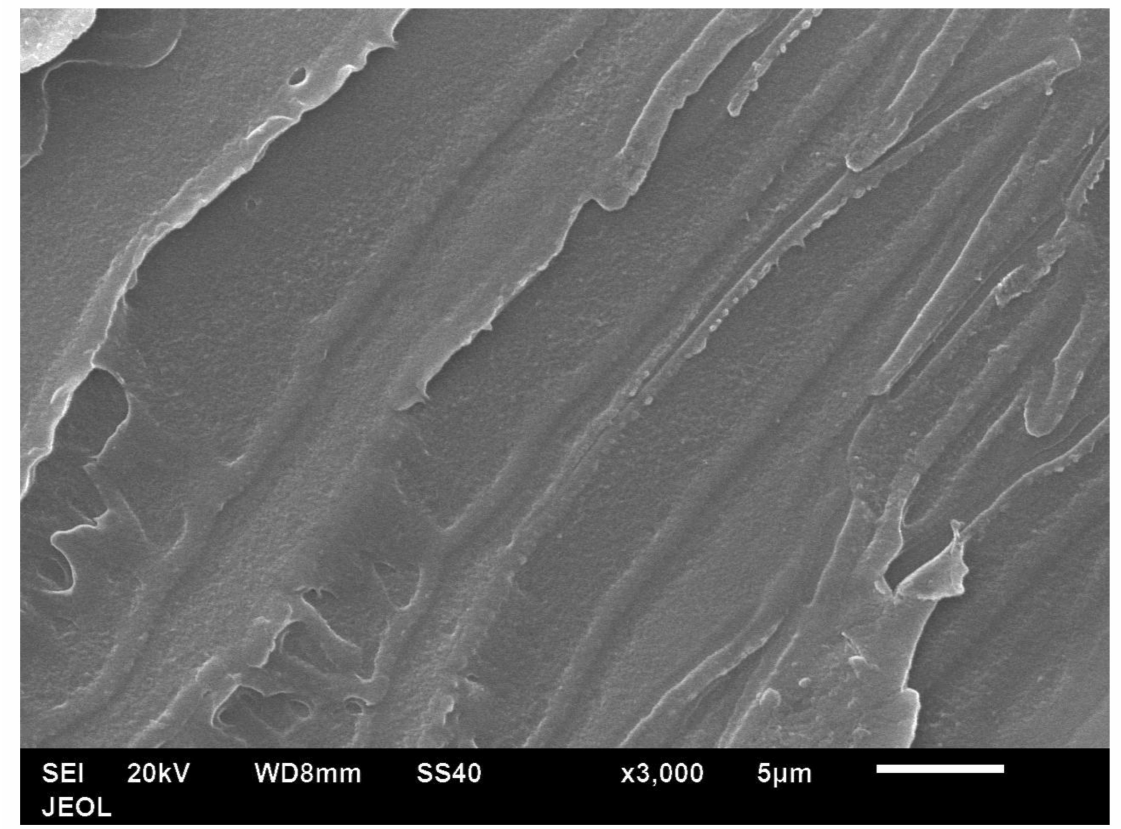
Figure 13. Fracture surface of the amorphous